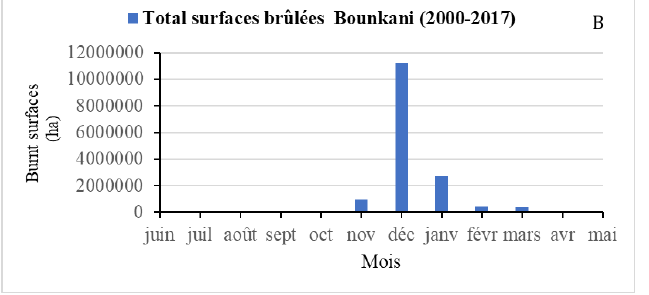
Figure 7: Monthly distribution of the number of fires (a) and area burned (b) in the Bounkani region